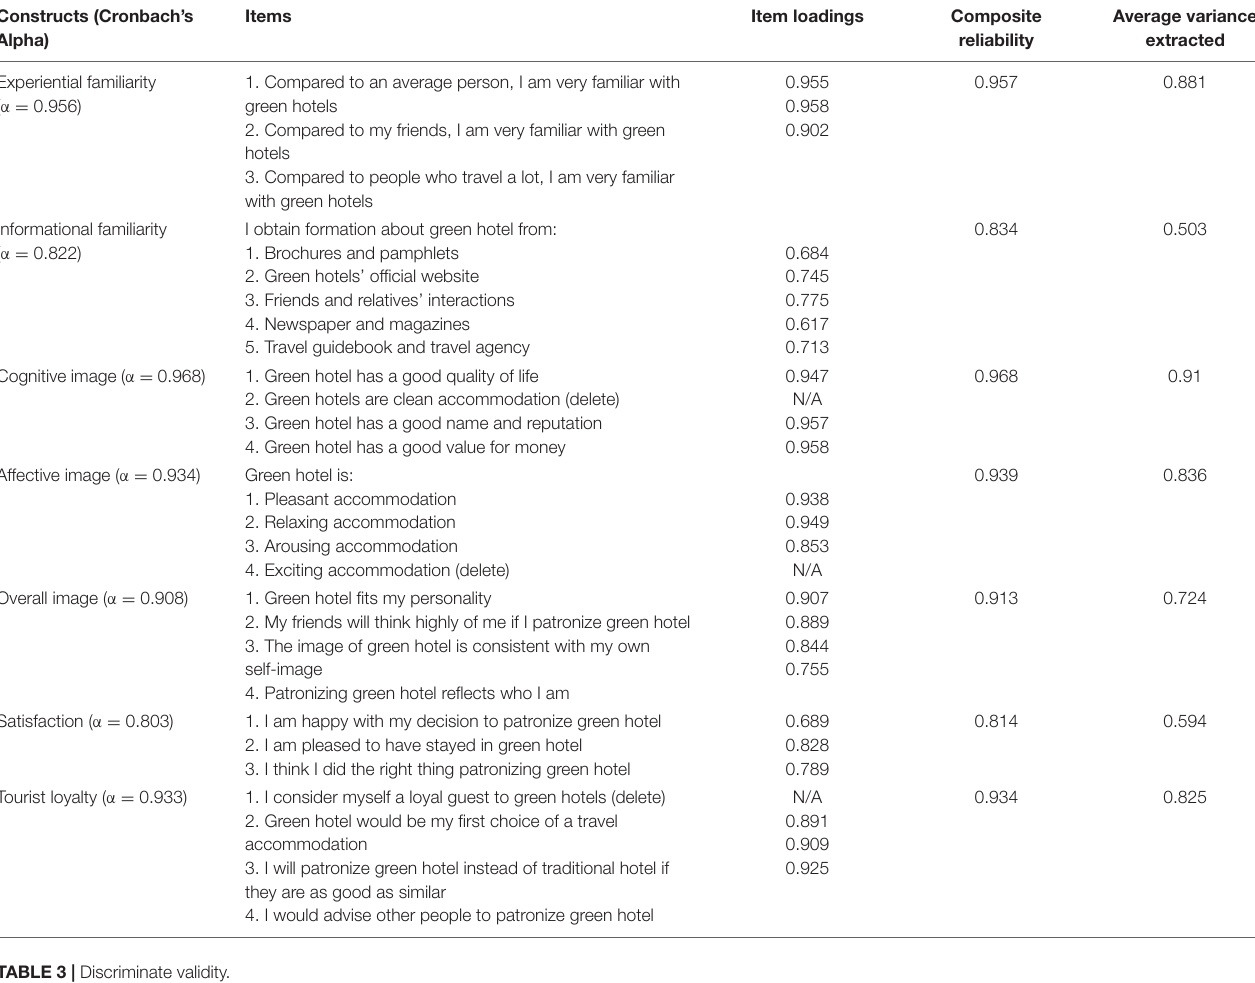
Items Item loadings Composite